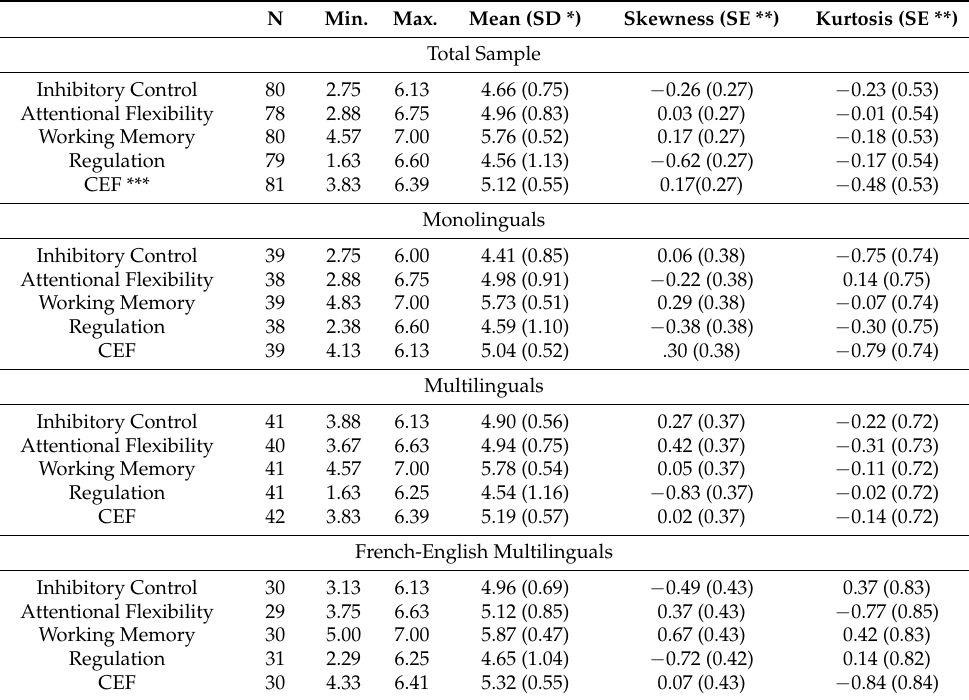
Table 2. Descriptive statistics of EEFQ